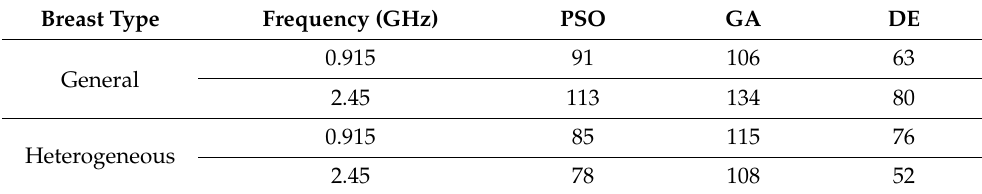
Table 5. Iteration number of three algorithms to reach PSO’s optimum solution.